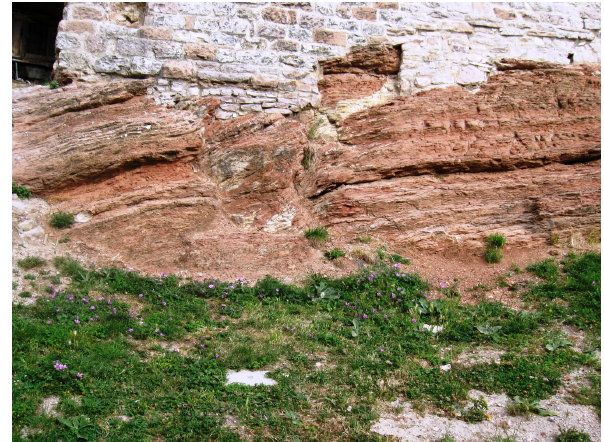
Figure 2. Pink streaked with white Scaglia Rossa limestone is a pelagic sedimentary rock with forams and clay in a coccolith matrix dating from the Late Cretaceous to Middle Eocene. It was mined from the Mt. Subasio quarry and used to construct the St. Francis